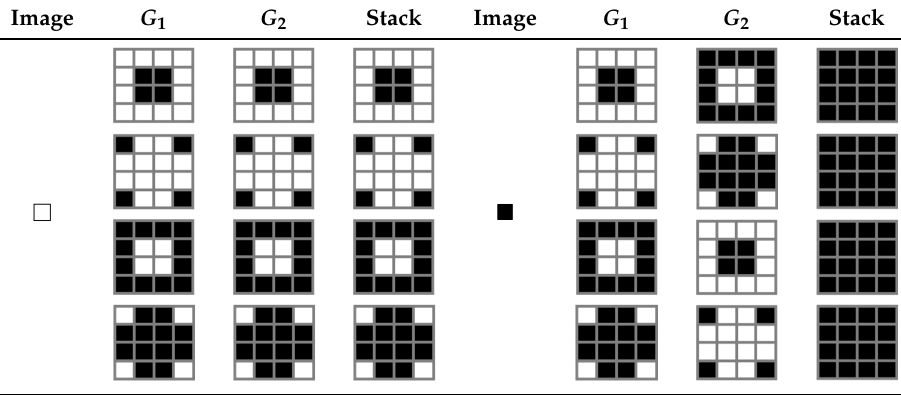
Table 4. The designed patterns for n = 4.